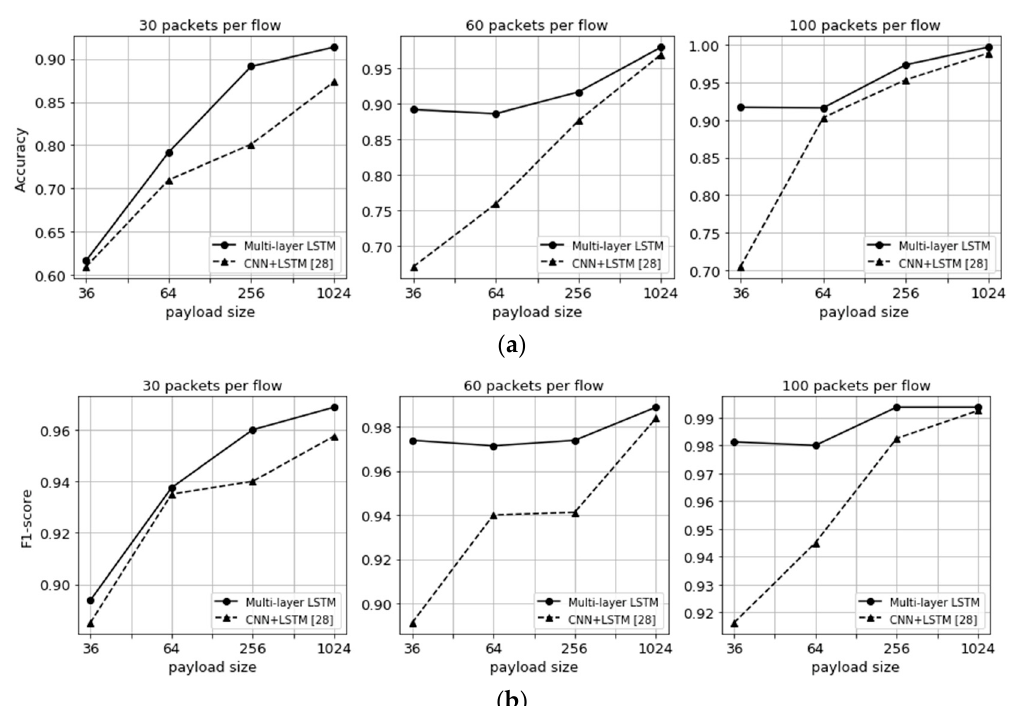
Figure 6. Performance comparison of the multi-layer (two-layer) LSTM and CNN + LSTM [28] models with accuracy and F1-score values in terms of the three numbers (30, 60, and 100) of packets per flow and the four imaged payload sizes. ( a ) Accuracy and ( b ) F1-Score.